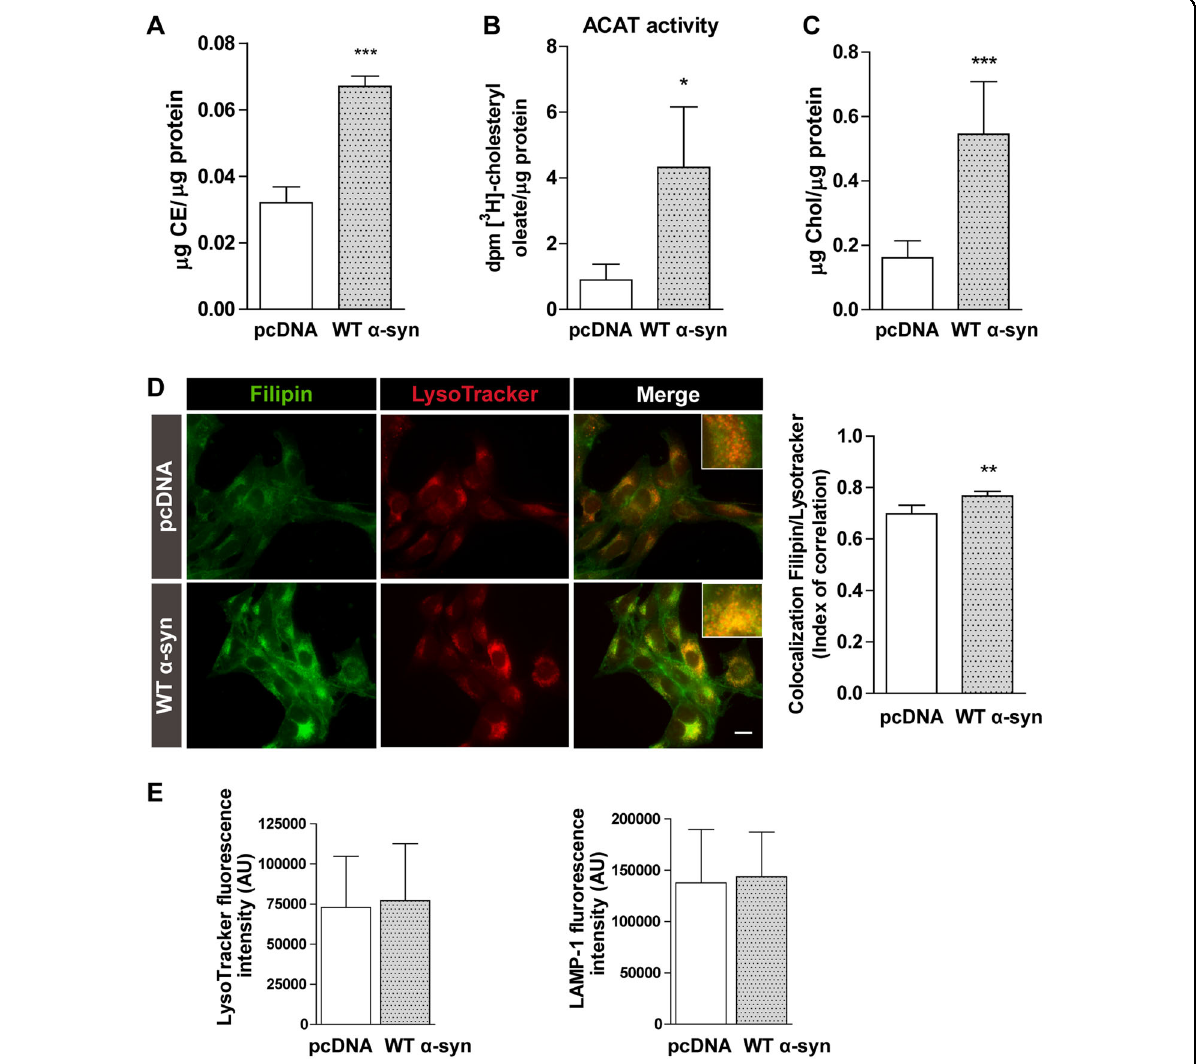
Fig. 3 α -syn overexpression alters chol homeostasis. A CE content was determined by a detection kit in pcDNA and WT α -syn cells. B ACAT activity was measured in our model by the incorporation of [ 3 H]-OA in chol. C Cellular chol was measured using a detection kit. D Chol stained with fi lipin co-localized with the lysosomal probe Lysotracker in cells overexpressing α -syn. E Quanti fi cation of fl uorescence intensity of lysosomal markers, Lysotracker and LAMP-1. All experiments were repeated three times. A – E Scale bars 20 µm. All experiments were repeated three times. Bars represent means ± standard deviation (SD, n = 3). * p < 0.05, ** p < 0.01, *** p < 0.001 with respect to the control